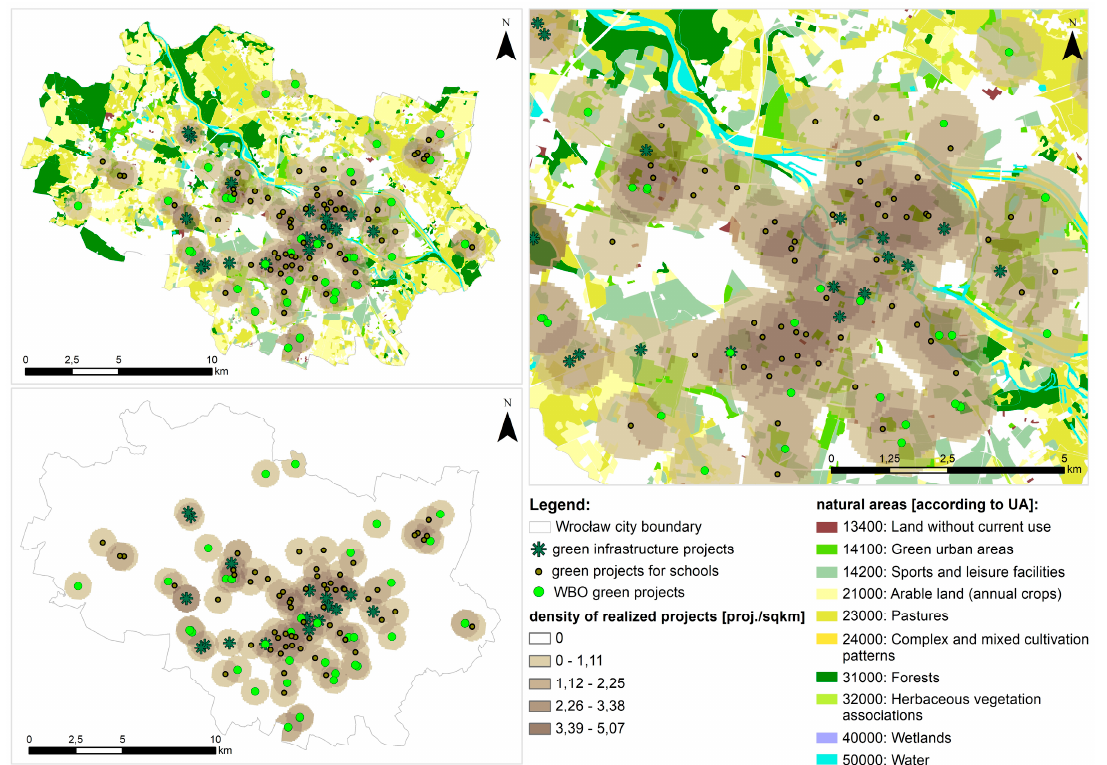
Figure 3. The green projects realized during period 2013–2018 in Wrocław. Top side of the figure shows the overview and density of projects regarding to natural areas in city (top-right figure shows the zoom to the city center). The lower section of the figure shows the overview and density map of projects [No. of projects per square kilometer]. Source: Own elaboration using ArcGIS software.